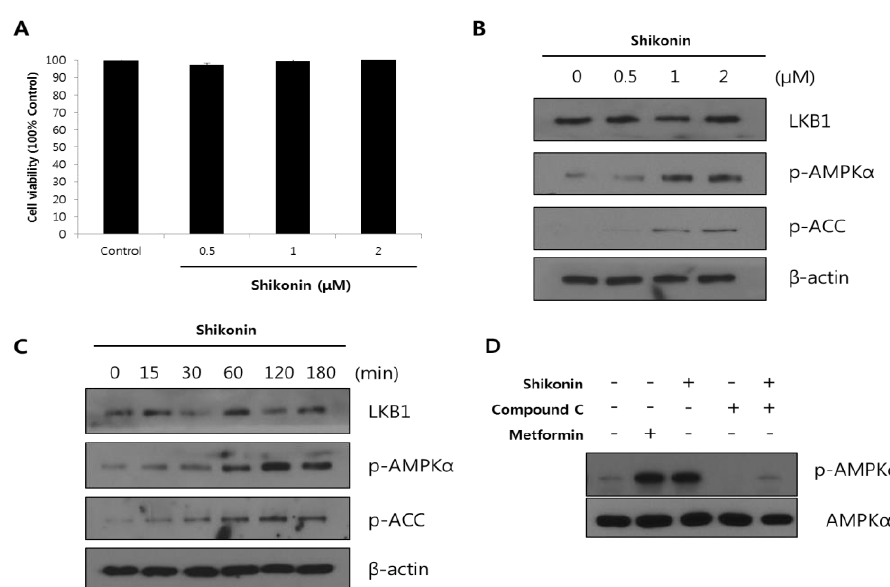
Figure 1. Shikonin stimulates the phosphorylation of AMP-activated protein kinase α (AMPK) and acetyl-CoA carboxylase (ACC) in Hepa 1-6 cells. Cell cytotoxicity was determined by MTT assay ( A ). Hepa 1-6 cells were treated with the indicated concentrations of shikonin for 1 h ( B ) or with 2 μM shikonin for various durations ( C ). Effect of AMPK inhibitor on phosphorylation of AMPKα in Hepa 1-6 cells treated with shikonin ( D ). Cells were treated with either compound C (40 μM) or metformin (2 mM) alone for 2 h, or exposed to 40 μM compound C for 1 h, then were treated with 2 μM shikonin for 2 h.